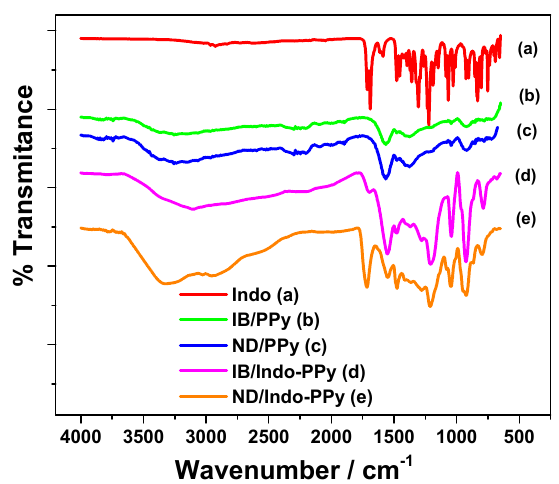
Figure 7. Representative FTIR spectra of electrochemically synthesized PPy (b,c) and PPy-Indo (d,e) coatings on IB and ND alloy substrates from ILM-ACN based electrolyte containing 0.5 M Py and 0.0175 M Indo. The spectrum of pure Indo (a) is also shown.